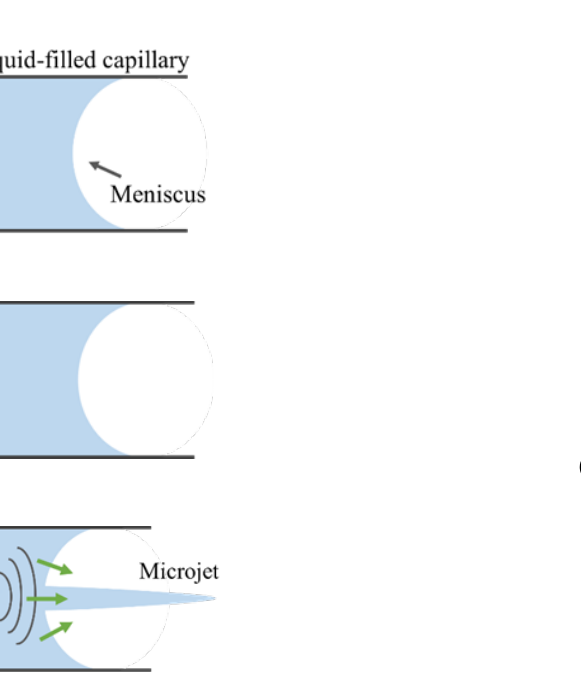
Figure 1. Illustration of the generation of microjets by focusing a pulsed laser in liquid-filled capillary. ( a ) Laser-induced bubbles is created by a focused laser pulse. ( b ) High-pressure laser-induced bubbles induce pressure waves toward the meniscus. ( c ) Microjet is generated due to kinematic focusing on the meniscus.